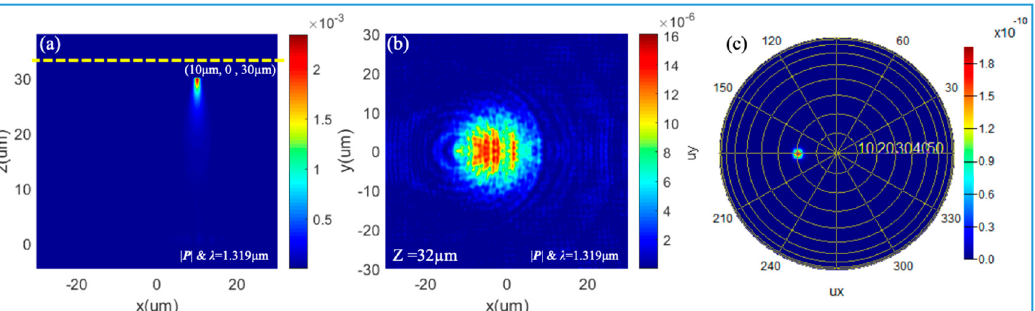
Figure 7. Deflecting features of meta-reflectors: ( a ) A Gaussian source is localized on the focal plane with coordinates (10 µ m, 0, 30 µ m), which is reflected by the meta-reflector with DBR in Figure 4a; ( b ) Intensity distribution on the x-y plane, marked by a yellow dot line in ( a ); ( c ) Intensity distribution of the reflected light in the coordinate system of inclination angle and azimuth angle.